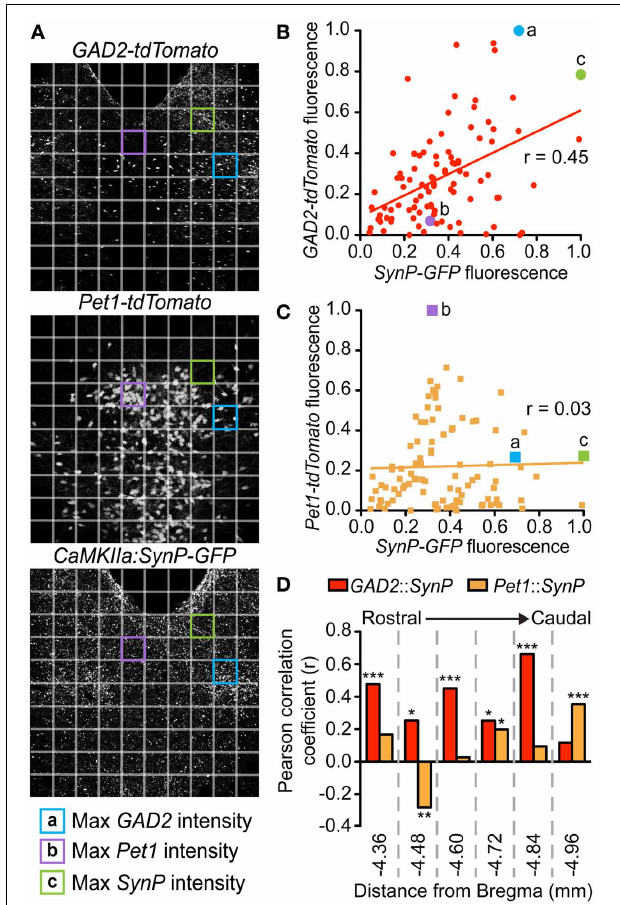
FIGURE 3 | Topographic distribution of vmPFC terminals correlates with GABAergic populations in the DRN. At each of the 6 rostrocaudal levels of the DRN, images of each fluorescent signal were divided into a 10 × 10 grid. Relative intensities were calculated for each of the SynP-GFP (vmPFC terminals), GAD2-tdTomato (GABA neurons) and Pet1-tdTomato (5-HT neurons) fluorescent signals for each box of the grid at every rostrocaudal level. (A) For example, depicted here are DRN slices at − 4.60mm from Bregma. Highlighted grid boxes depict areas that were calculated to have the highest (a) GAD2-tdTomato intensity, (b) Pet1-tdTomato intensity and (c) SynP-GFP intensity. Intensity values of SynP-GFP were correlated with that of (B) GAD2-tdTomato or (C) Pet1-tdTomato at each of the 6 rostrocaudal levels. These were graphed on scatter plots with (x,y) coordinates plotted as ( SynP-GFP intensity, tdTomato intensity). Grid boxes highlighted in (A) are plotted in (B) and (C) as examples. Pearson’s correlation coefficients (r) were calculated for GAD2-tdTomato or Pet1-tdTomato vs. SynP-GFP with r = 1 signifying strong correlation, r = 0 signifying no correlation and r = − 1 signifying strong negative correlation. (D) Overall there is a stronger correlation of topographic distribution of GABA neurons with vmPFC terminals than 5-HT neurons except in the most caudal DRN. (Bars with asterisks indicate Pearson coefficients that are significantly non-zero; ∗ p < 0 . 05, ∗∗ p < 0 . 005, ∗∗∗ p < 0 .